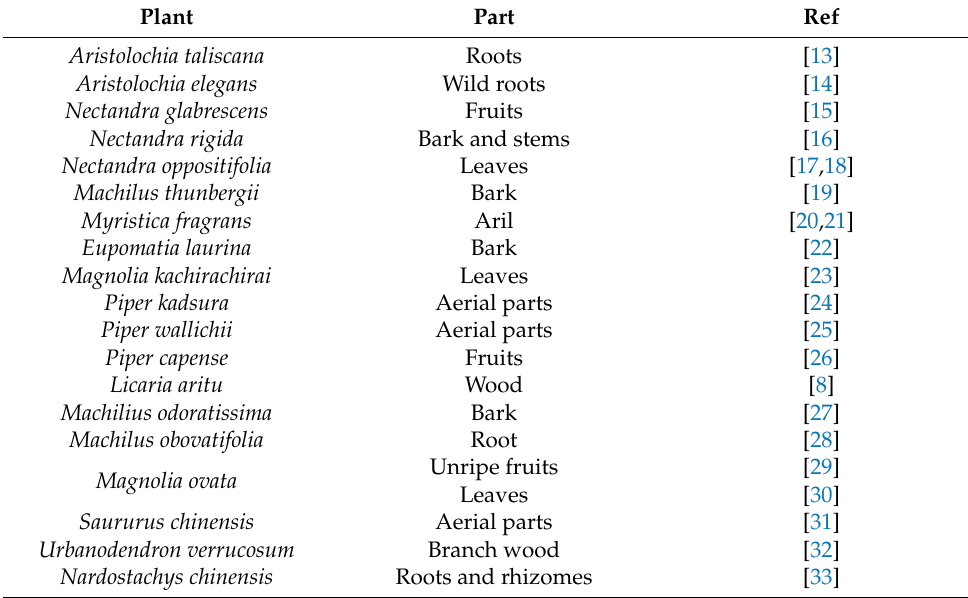
Table 1. Natural sources of DHIE.